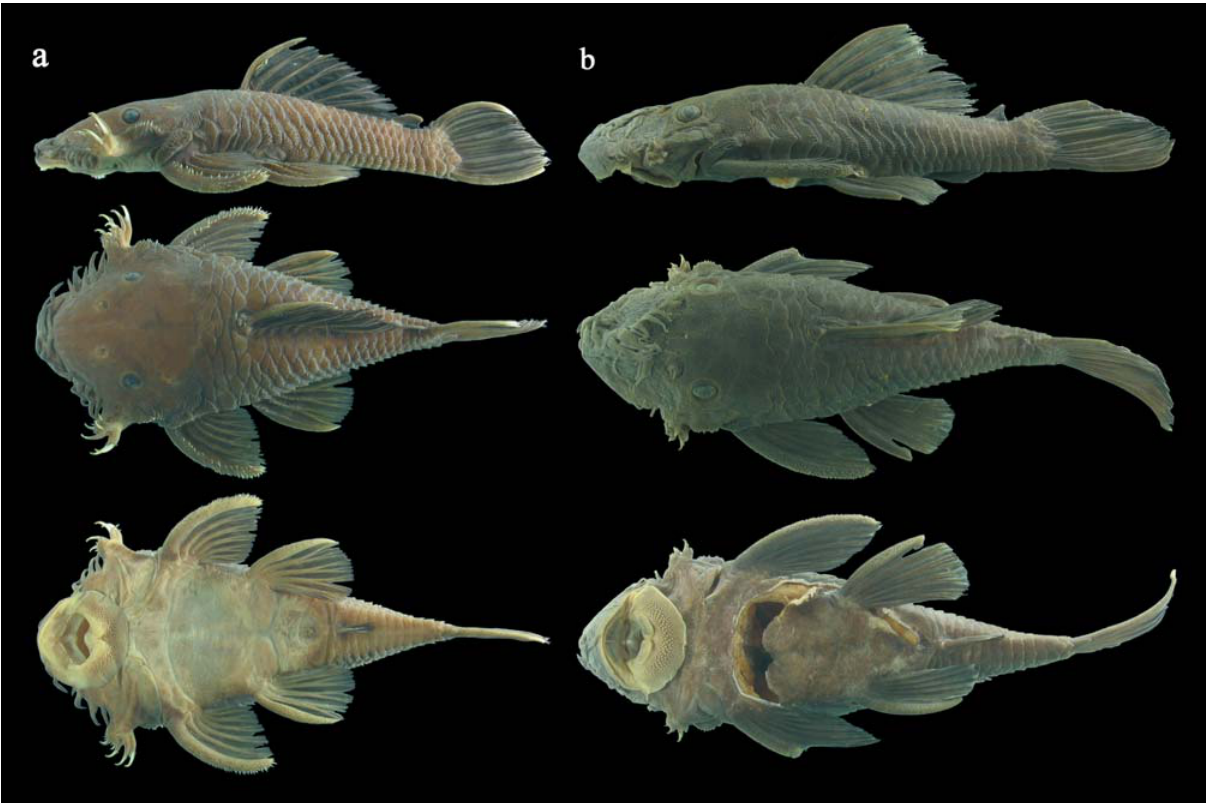
Fig. 1. Lateral, dorsal and ventral views of Ancistrus ranunculus , INPA 25624, 103 mm SL (a), and of Ancistrus sp. “Piagaçu”, INPA 25630, 128 mm SL